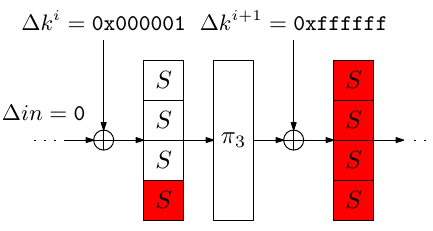
Figure 4: Example for model considering π 3 . Active S-boxes in